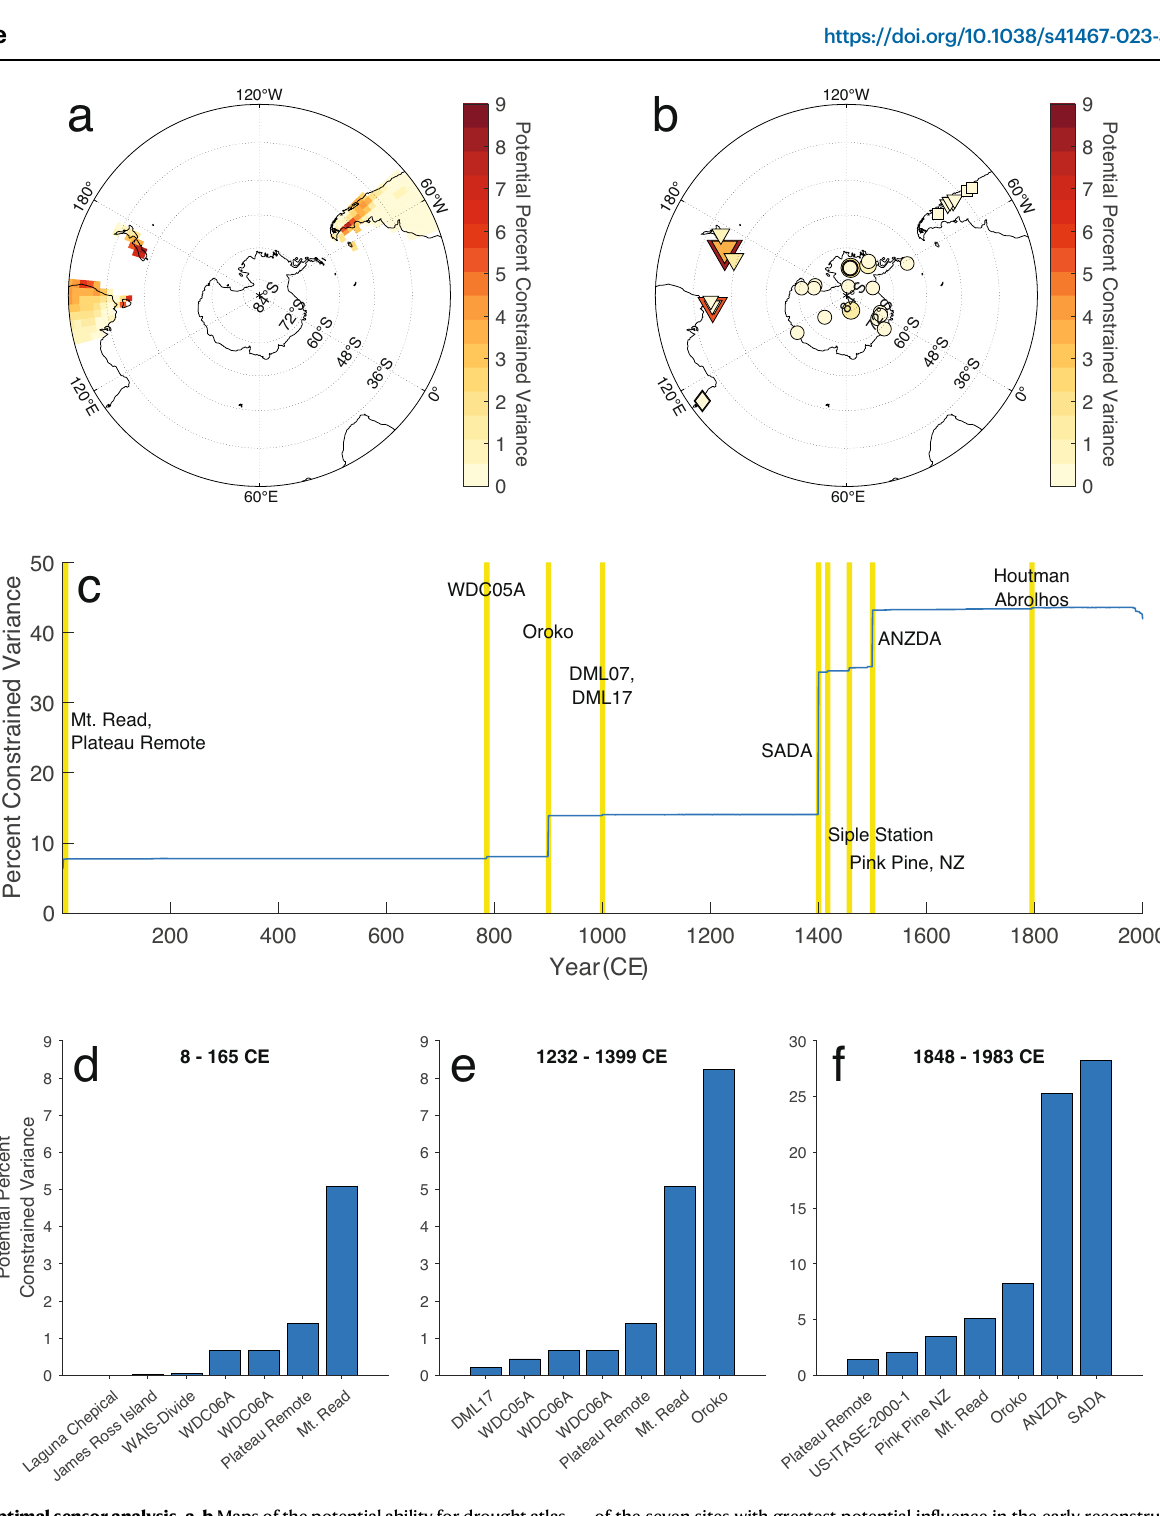
of the seven sites with greatest potential in fl uence in the early reconstruction ( d